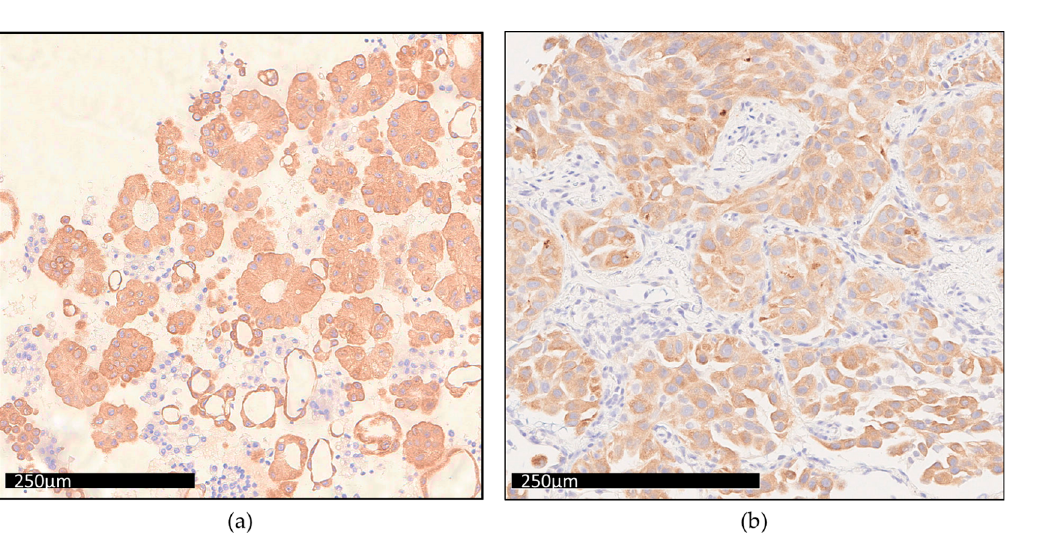
Figure 7. Validation of ALK and ROS1 gene rearrangements by immunohistochemistry analysis. ( a ) Tumor cells strong and diffuse cytoplasmic expression for ALK in bronchoalveolar lavage obtained from papillary adenocarcinoma. ( b ) Tumor cells strong positive staining for ROS1 in a tissue section from lung adenocarcinoma.